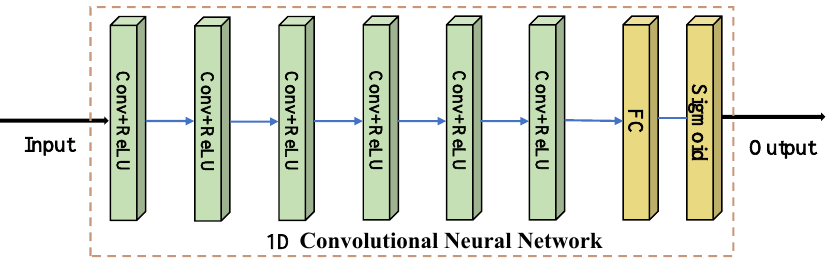
Figure 2. Schematics of the architecture of ordinary 1D-CNN, which is composed of convolution layers and pooling layers with the capability of feature